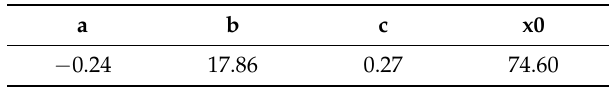
Table 2. Estimated parameters in Equation (4) and the critical point in the temperature–humidity index